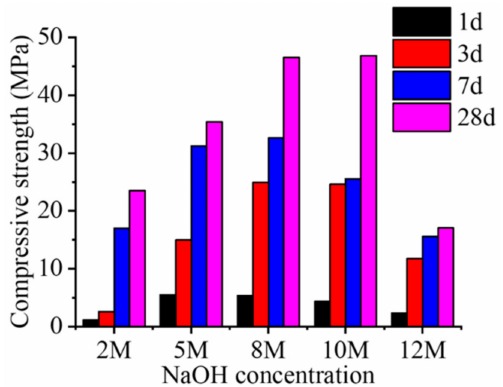
Figure 2. Compressive strength of AA–BFFS mortar at different